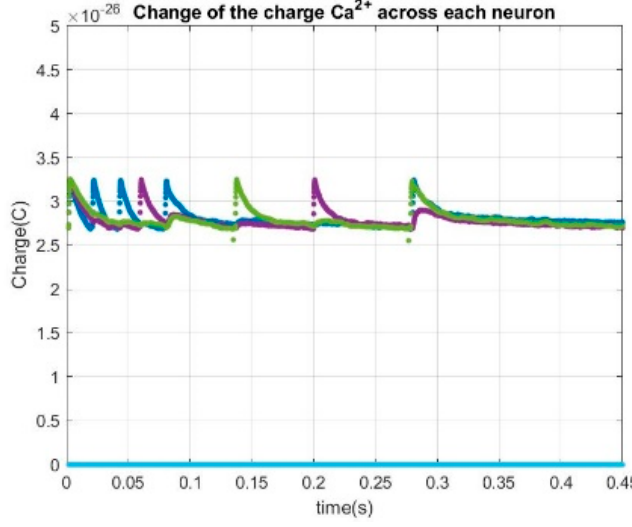
Figure 3. Change in the charge of Ca 2+ across the membrane of each neuron.